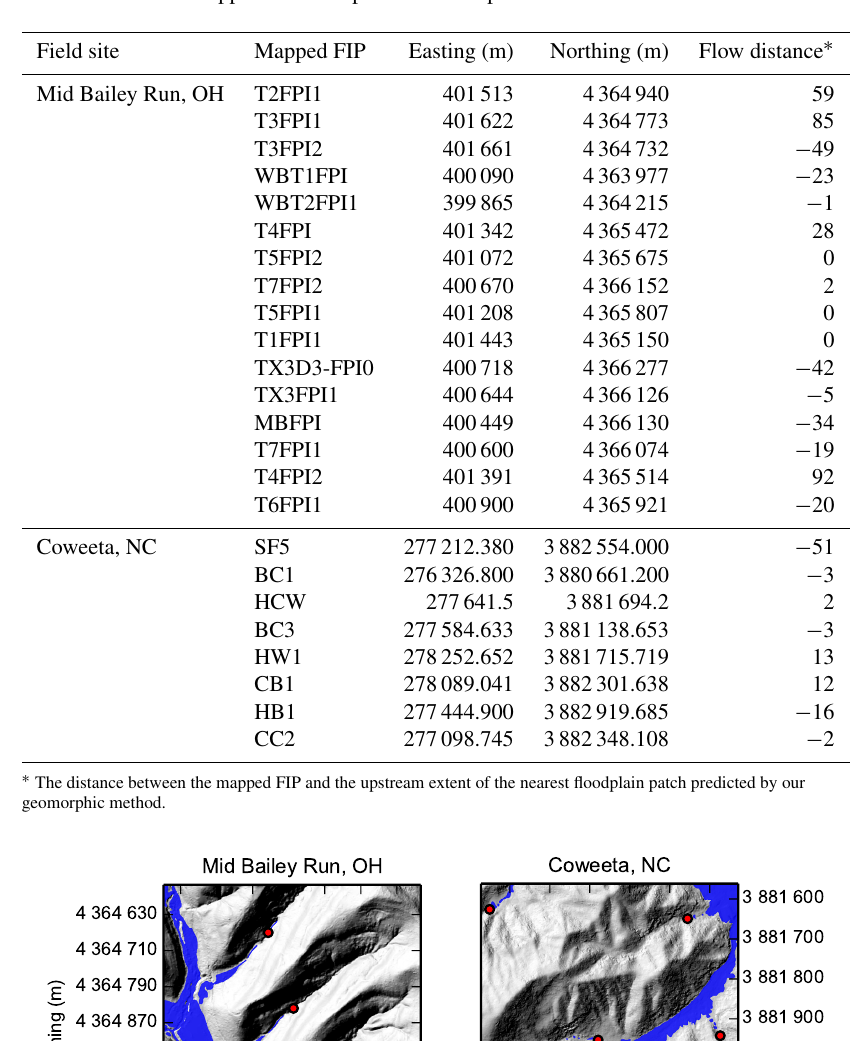
Table 3. Flow distances between the field-mapped FIPs and predicted floodplain extents